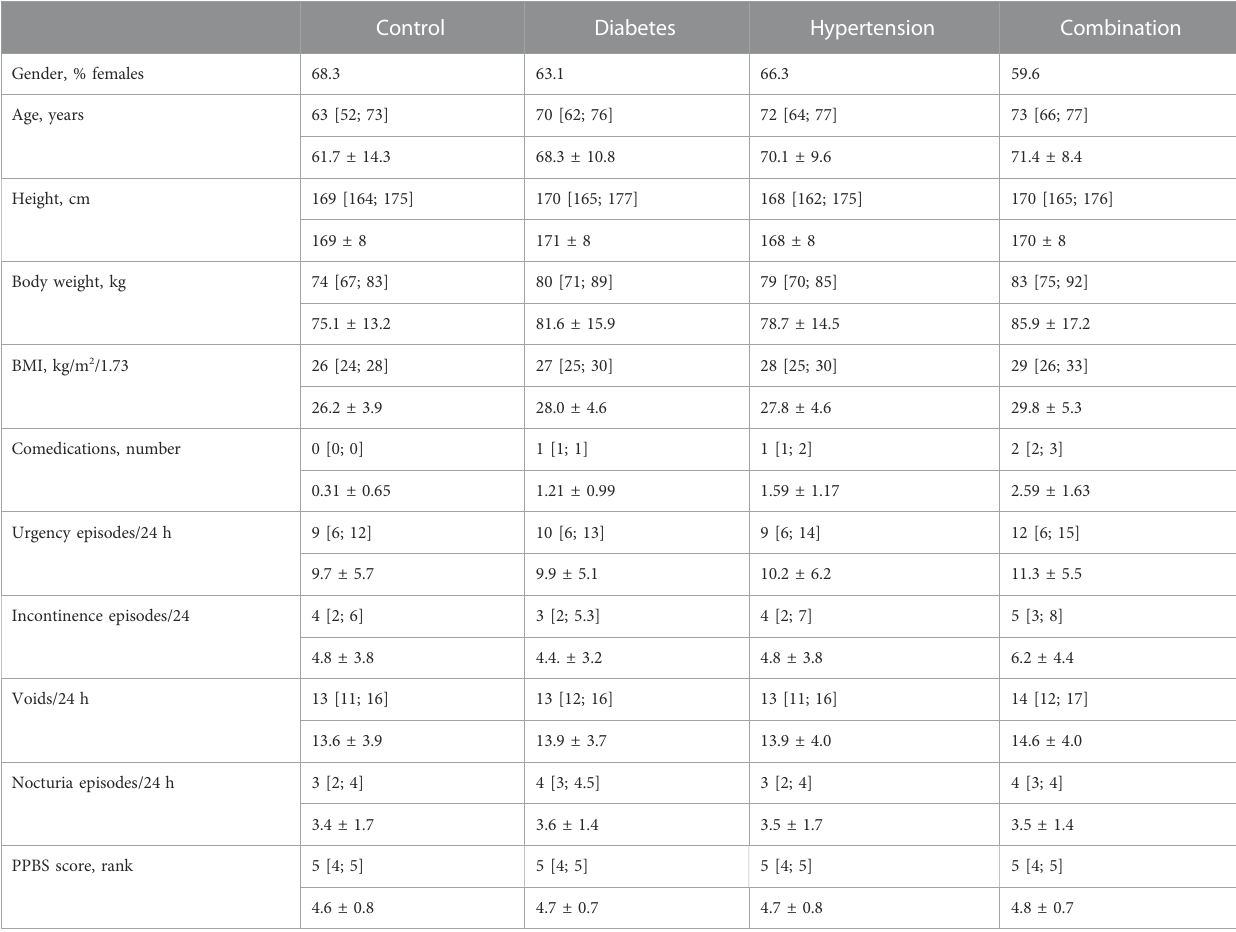
TABLE 1 Demographics and baseline data from study I Data are shown as medians with inter-quartile ranges and as means ± SD in parentheses except for categorical variables that are shown as % of cohort. Data on baseline symptoms are shown only for those exhibiting a pathological value at